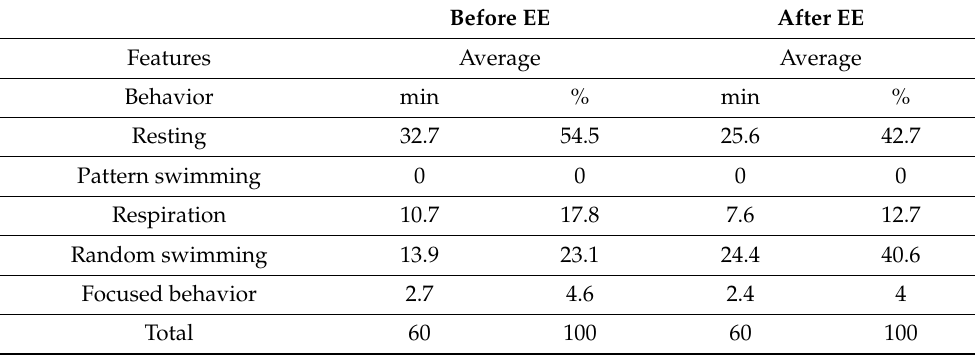
Table 1. Ethogram showing evaluated behaviors before and after environmental enrichment (EE). Before EE After EE Features Average Average Behavior min Resting Pattern swimming